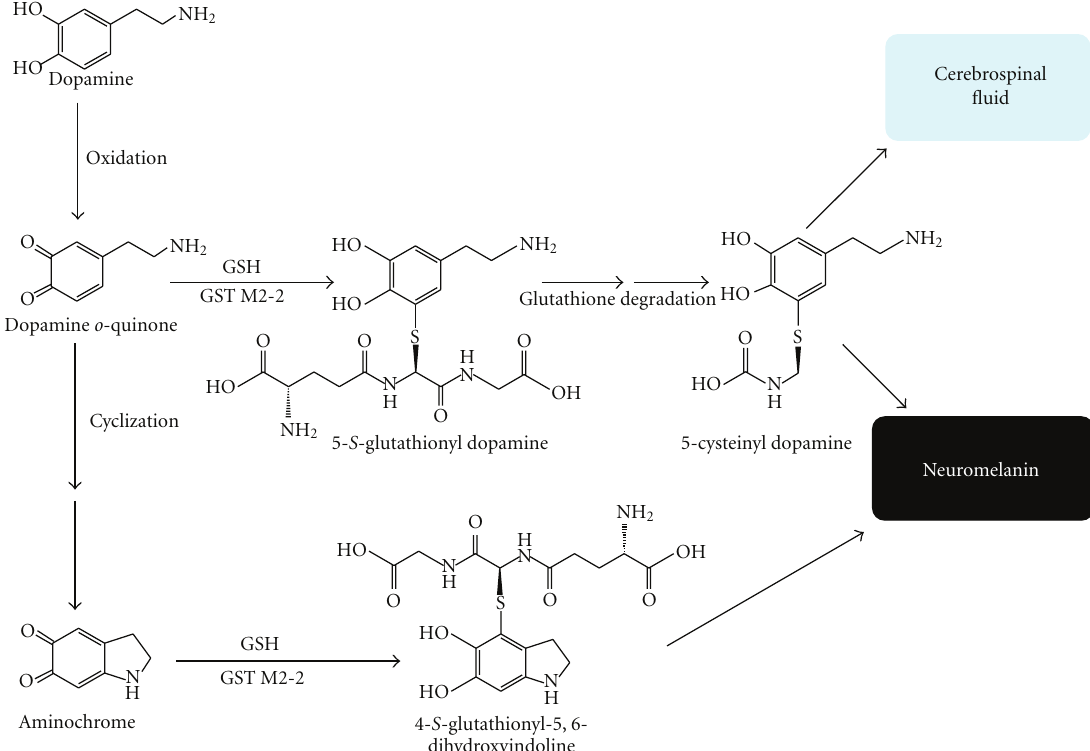
Figure 8: Glutathione conjugation of dopamine o -quinone and aminochrome. GST M2-2 catalyzes conjugation of both aminochrome and its precursor dopamine o -quinone to 4- S -glutathionyl-5,6-dihydroxyindoline and 5-glutathionyl-dopamine, respectively. 5-Glutathionyl- dopamine undergoes degradation to 5-cysteinyl dopamine that have been found in both the cerebrospinal fluid and